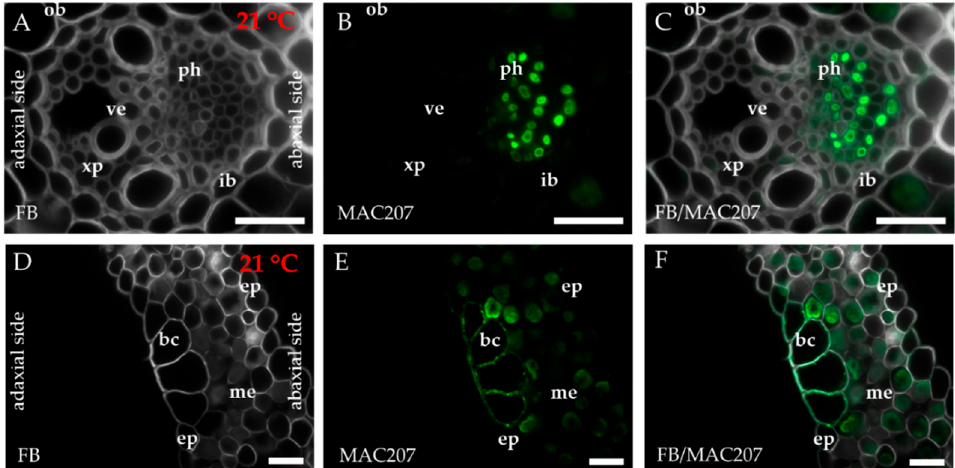
Figure A3. Immunolocalisation of the MAC207 epitope in cross ‐ sections of B. distachyon leaves (21 °C), ( A – C ): through the major vascular bundle; ( D – F ): through the mesophyll and bulliform cells. Abbreviations: ep—epidermis, b—bulliform cells, FB—fluorescent brightener, ib—inner bundle parenchyma. The green colour shows epitope occurrence. Scale bars: 20 μ m.